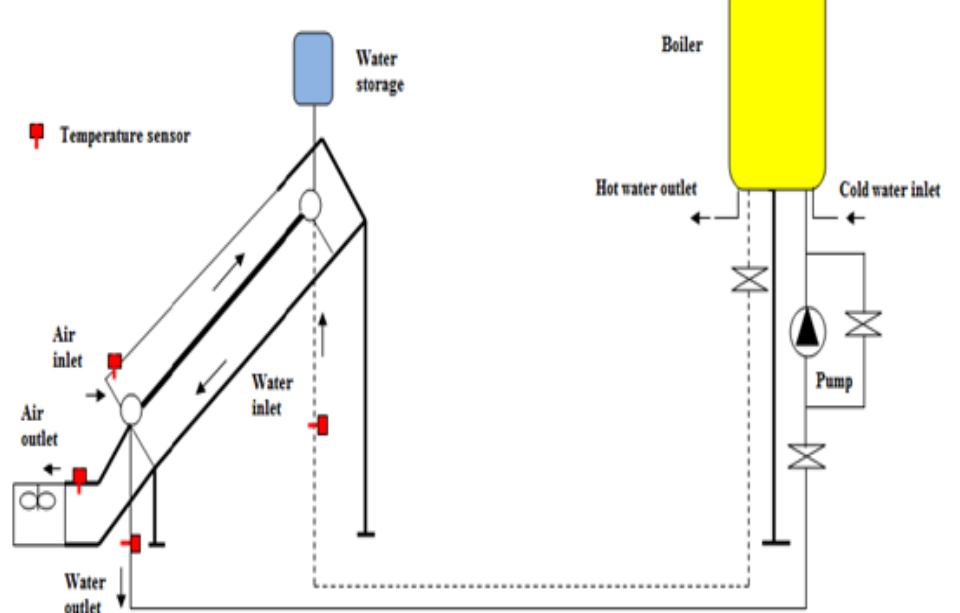
Figure 5. The air and water circuits of module-3 [21].